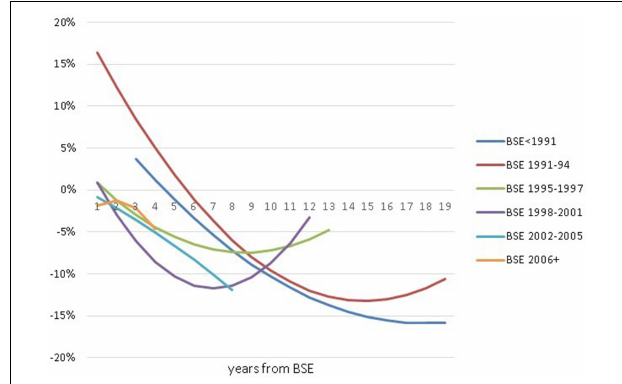
FIGURE 5 | Cohort-specific estimated time-paths of gender gaps in retention in engineering, calculated as the difference of the female and male retention rates by year-from-BSE predicted from regression. Data Source: NSF SESTAT Surveys